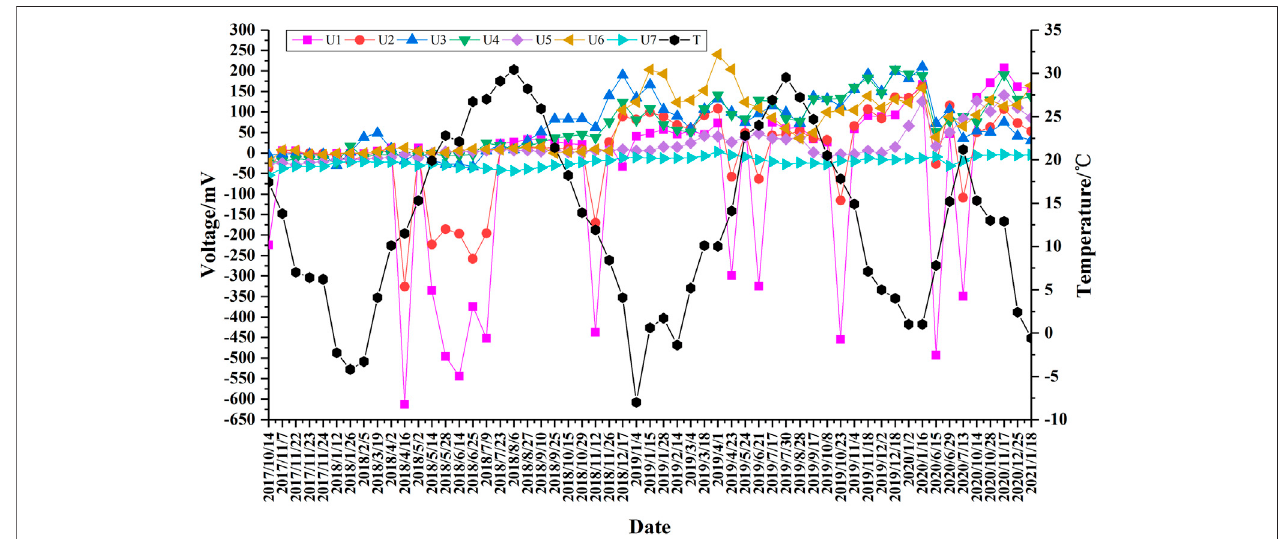
FIGURE 8 | Voltage between anode and